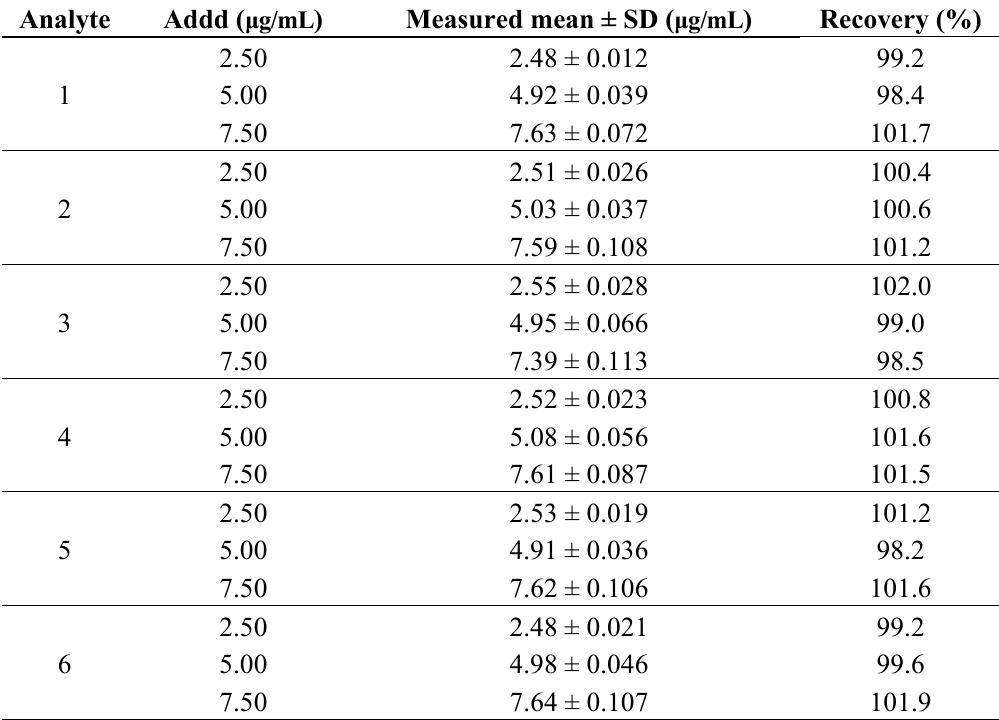
Table 4. The percent recovery of related substances of micafungin sodium from triplicate preparations.